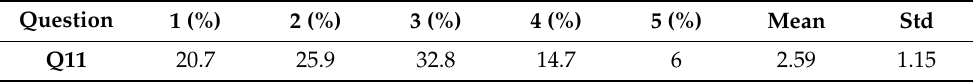
Table 6. Senior o ffi cers’ opinion on reporting practices onboard ships.